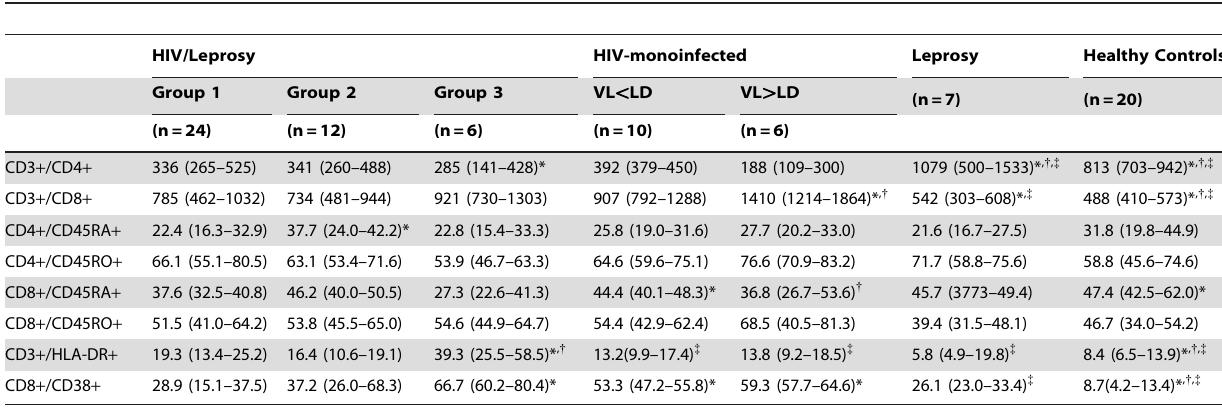
Table 1. Median and interquartile range (IQR) of T cell immunophenotyping percentage values or absolute counts obtained from HIV/leprosy individuals according to viral load (VL) values and from HIV-monoinfected, leprosy patients and healthy controls.